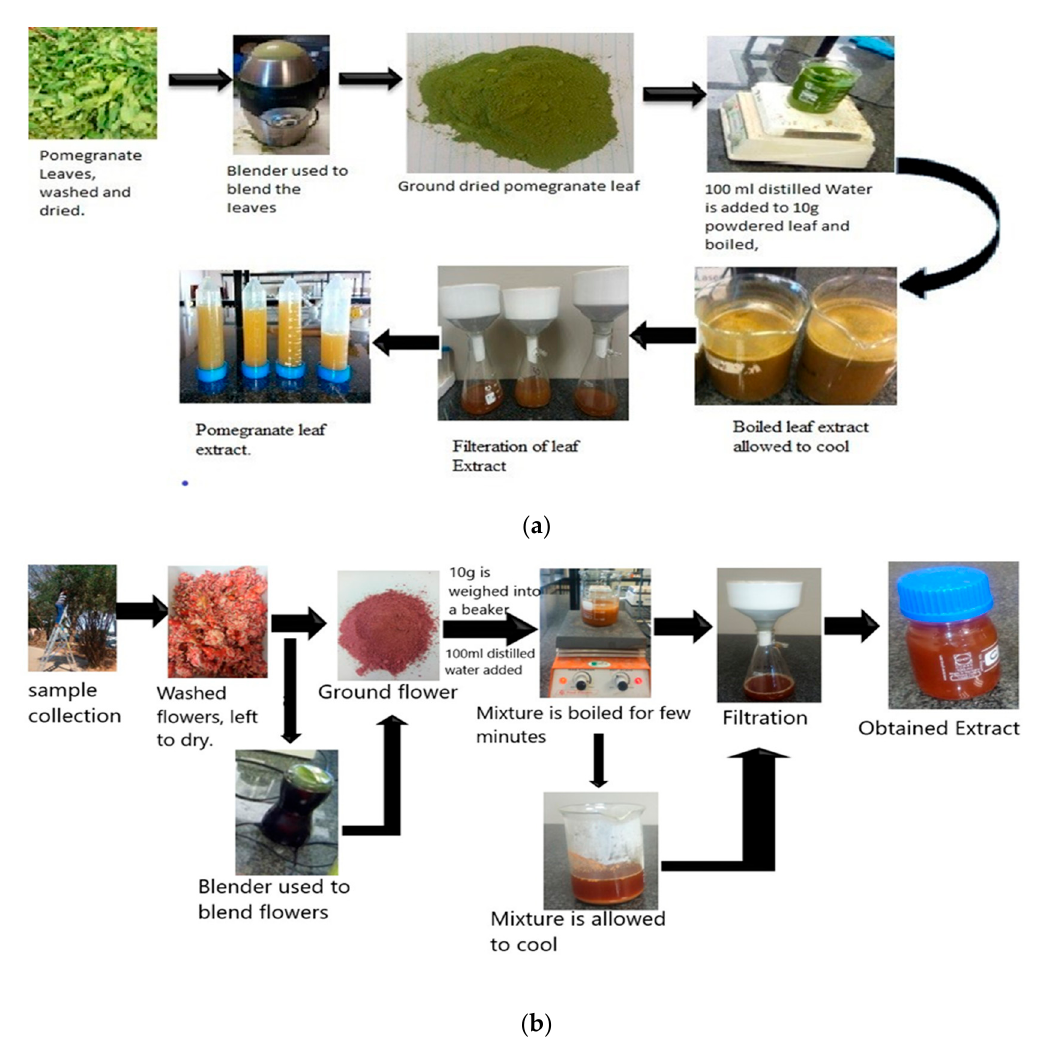
Figure 1. ( a ) Pictorial representation of the preparation process for pomegranate ( Punica granatum ) leaf extract. ( b ) Pictorial representation of the preparation process for pomegranate ( Punica granatum ) flower extract.